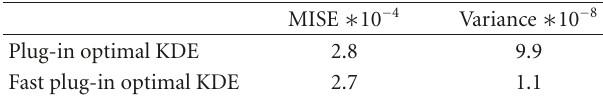
Table 2: MISE and variance of 100 simulations of the two studied